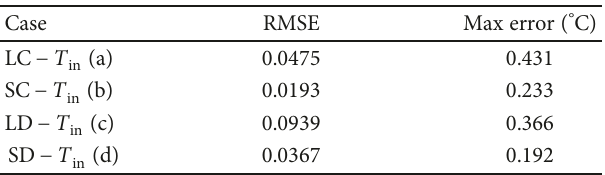
LC − T SC − T LD − T SD − T in ; (b) in ; (c) in ; (d) in . Table 5: Estimation errors for four validation data by using the solo RBF NN